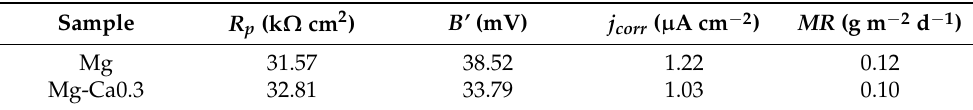
Table 2. Values of R p , j corr , B’ , and MR for Mg and Mg-Ca0.3 in Hank’s solution (at 27 ◦ C), estimated by PDP